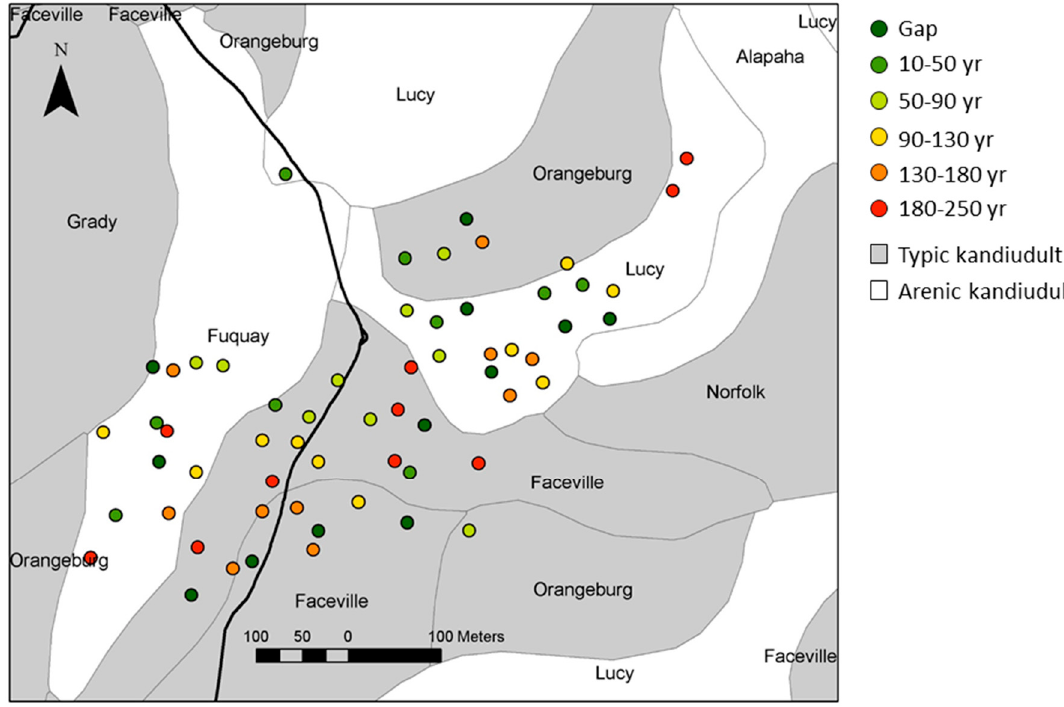
Figure A1. Map of the study site at the Wade Tract in Thomasville, GA. The points represent the locations of the selected study plots for each of the patch stages color-coded on the legend and their distribution on the east and west burn units and Arenic and Typica Kanduidult soil types. Table A1. Mean values of different longleaf pine population structure attributes in each of the six patch stages and overall stage effect p-value from PerMANOVA analyses. Bold p -values indicate significant results ( p < 0.05) and shared letter subscripts denote non-significant differences indicated by PerMANOVA pairwise comparisons.